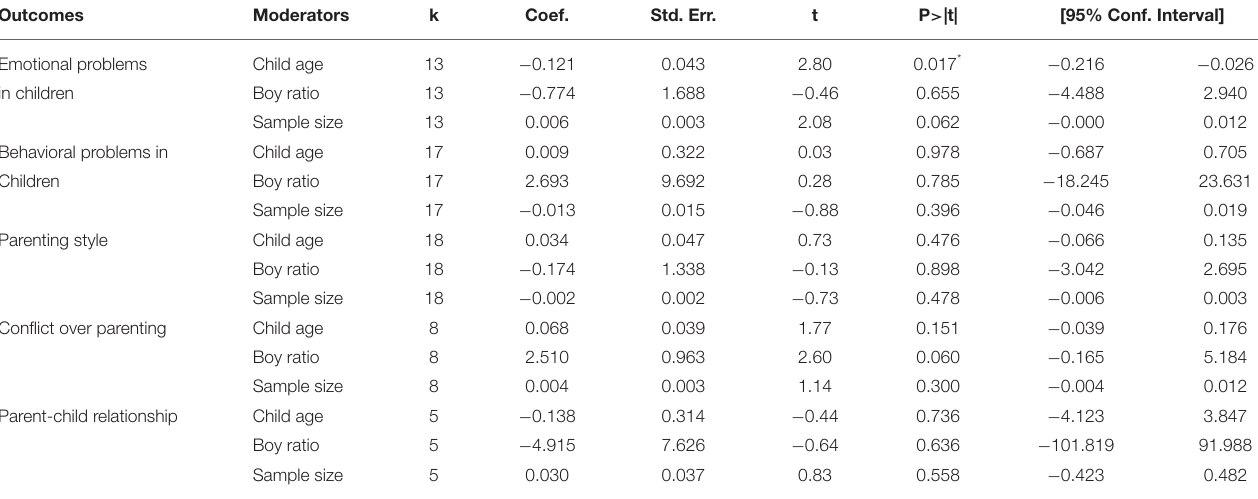
TABLE 4 | The results of the meta-regression analysis.